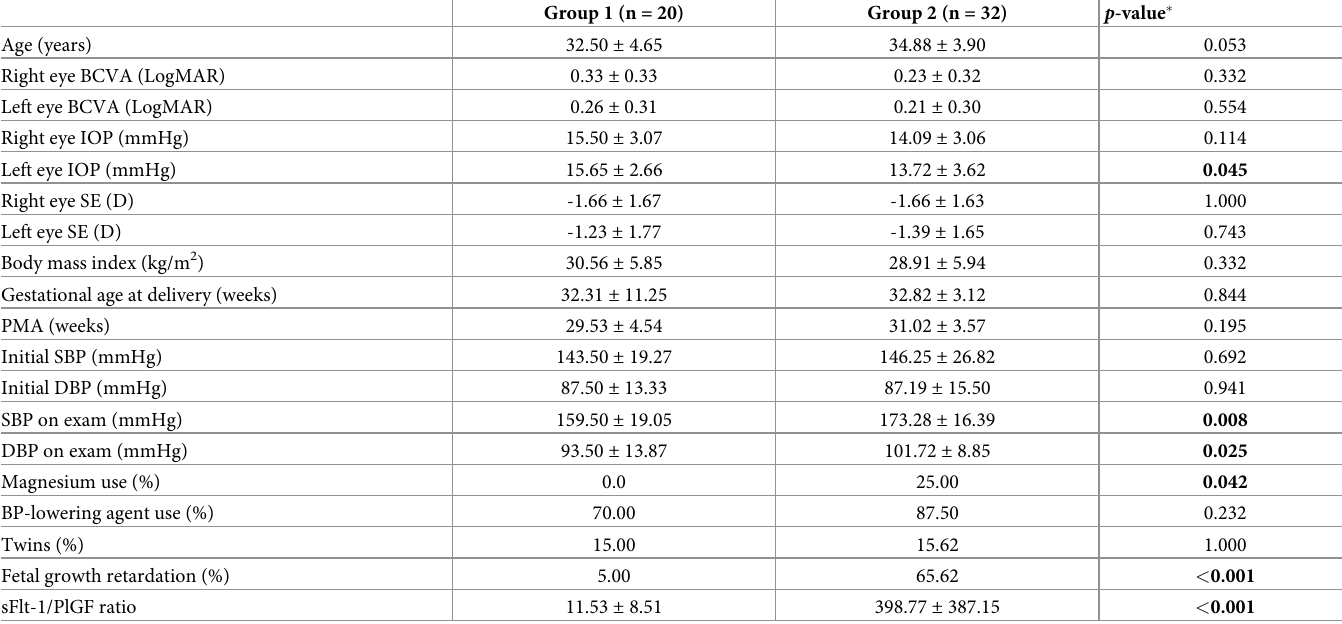
Table 1. Demographical and clinical features of pregnant women with